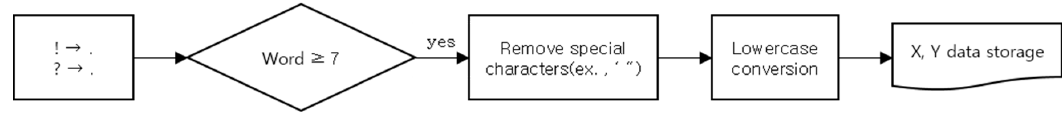
Figure 2. Data Preprocessing.